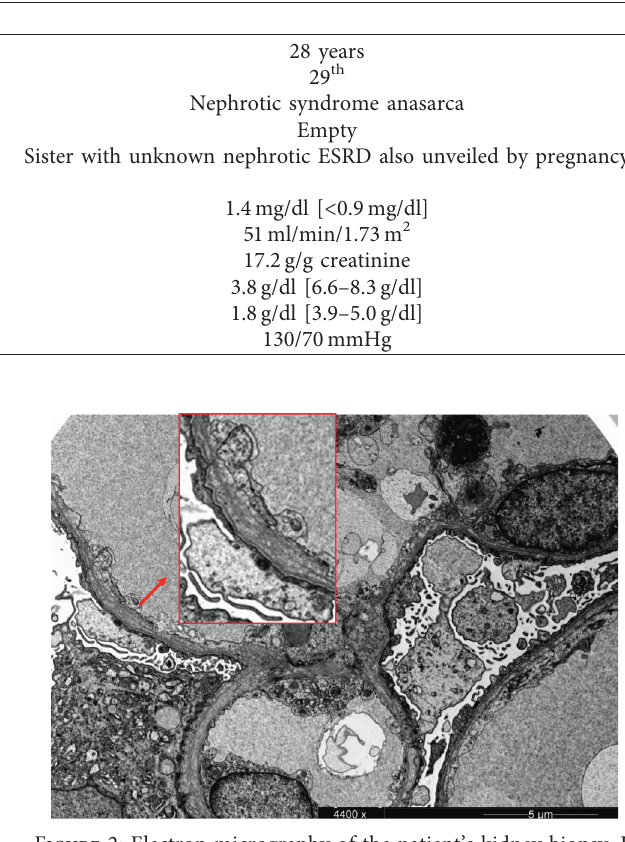
Table 1: Initial patient’s characteristics and laboratory results.